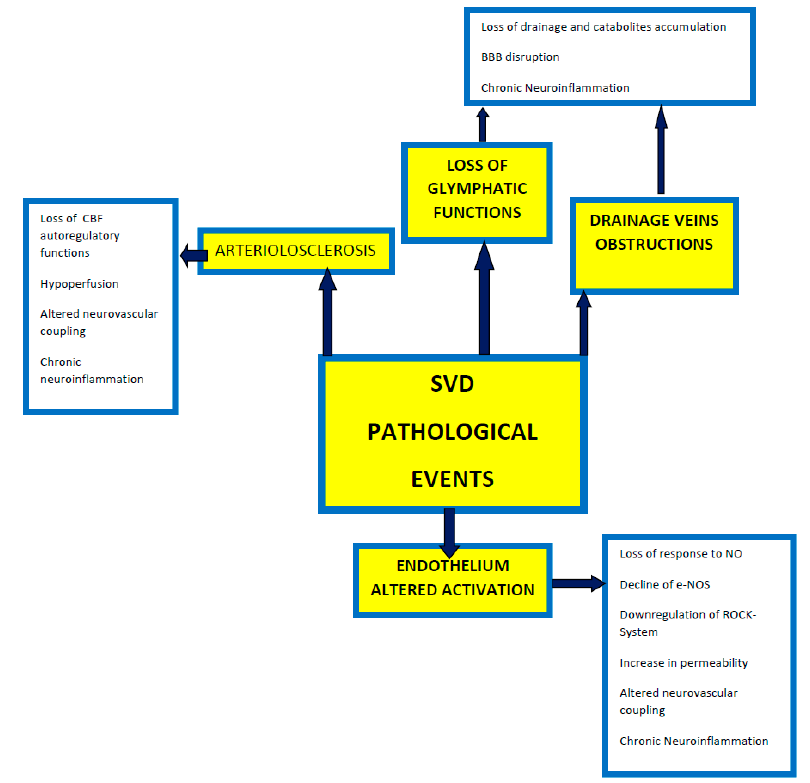
Figure 2. A synoptical overview of the pathological events which occur in SVD (Small Vessel Disease) (abbreviations: BBB = blood–brain barrier; eNOS = endothelium-derived NO synthase; NO = Nitric oxide; ROCK = Rho-associated protein kinase; SVD = Small Vessel